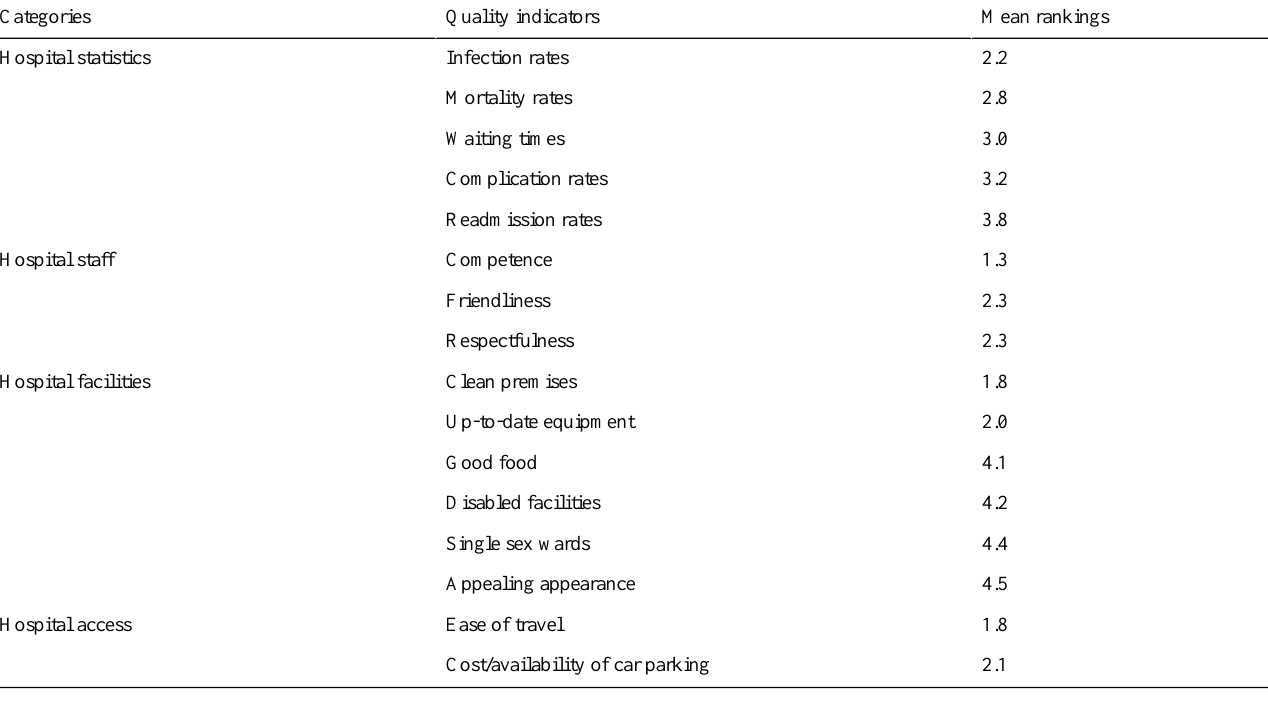
Table 1. Mean rankings of quality indicators within each category.